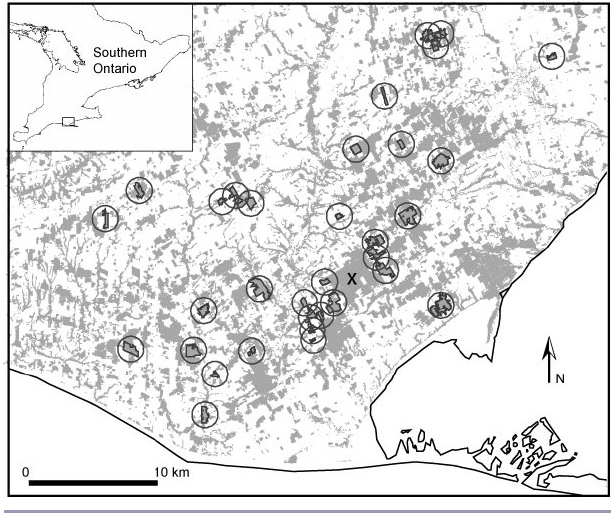
Fig. 1 . Area of study region ( @ 1256 km²) in southern Ontario (UTM Northing 4,715,834; Easting 521,808) showing all wooded areas in grey. Forested patches ( n = 33) surveyed for S. citrina between 2004 and 2005 are outlined in black. Each patch is surrounded by a circular ‘landscape’ 2 km in diameter. Patches were selected within 20 km of the core population, St. Williams’ Crown research forest (indicated by an